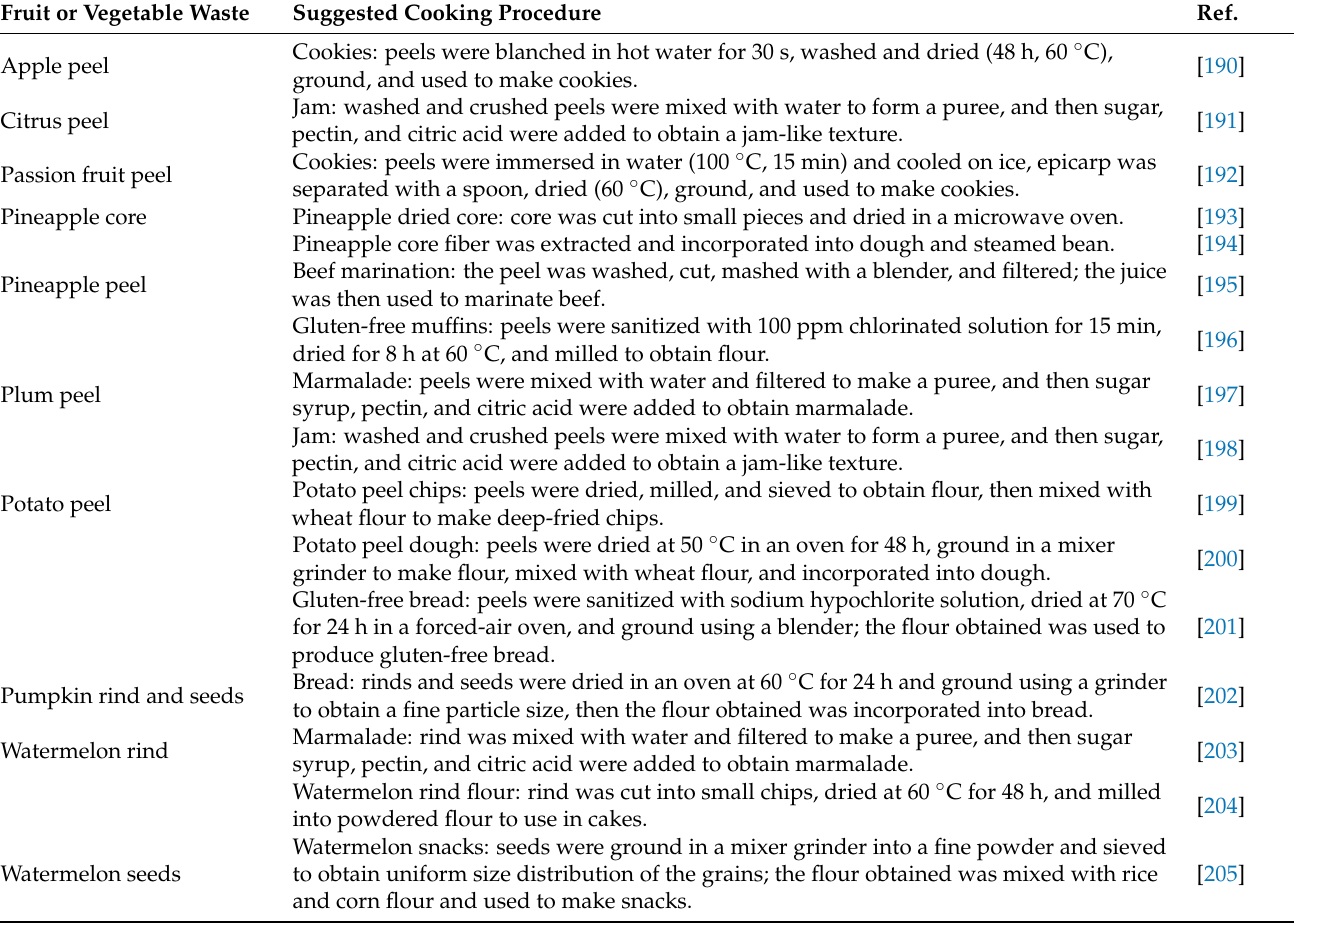
Table 2. Examples of possible uses and cooking procedures for several fruit and vegetable